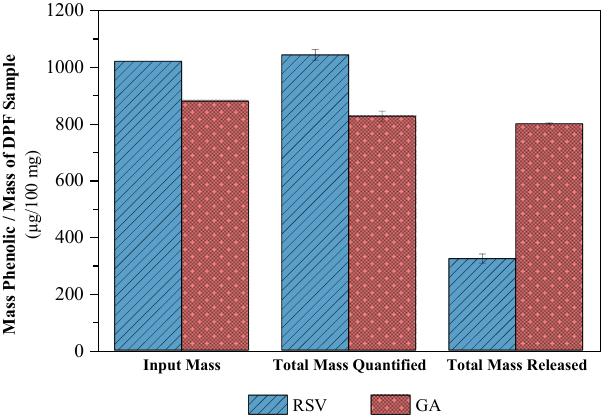
Figure 13. Input, total quantified (in ethanol), and total released (in pH 5.5 PBS) masses of RSV and GA expressed in µg of phenolic per 100 mg of total DPF sample.